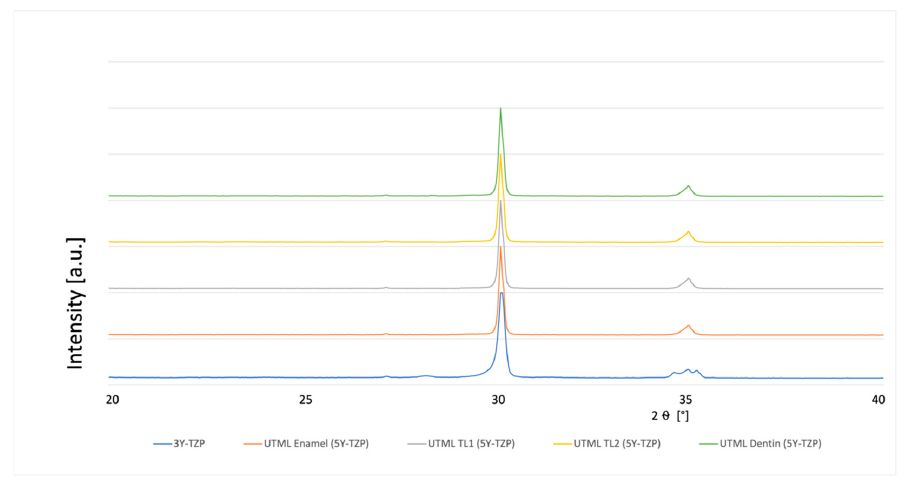
Figure 7. XRD analysis 3Y-TZP and 5Y-PSZ polished up to 1 µm and pre-sintered at cutting.